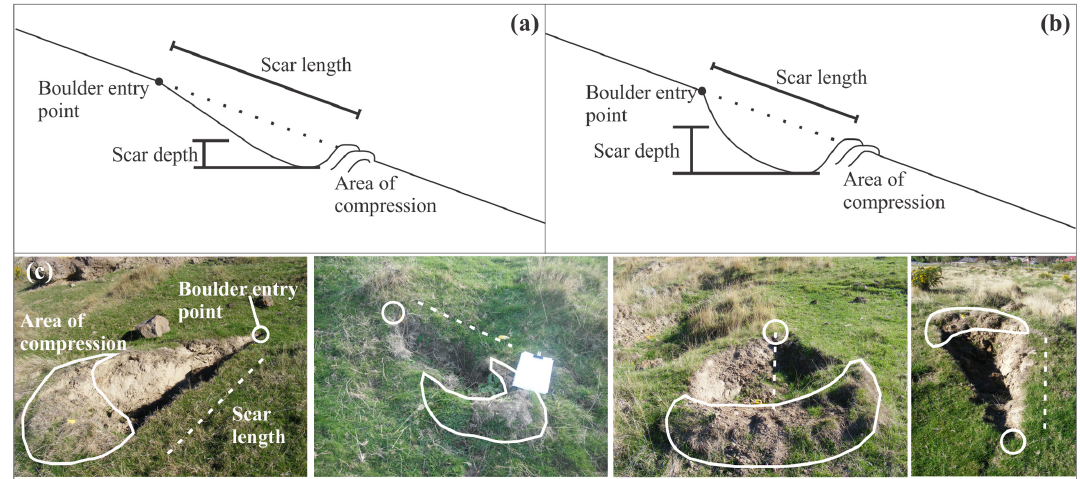
Figure 6. (a) Schematic representation of impact scar morphology, where depth:length of the scar ratio is low, representing dry conditions, and where it is high, representing wet conditions (b) . (c) Images of impact scars from Rapaki Bay showing typical scar morphology from four different boulders.